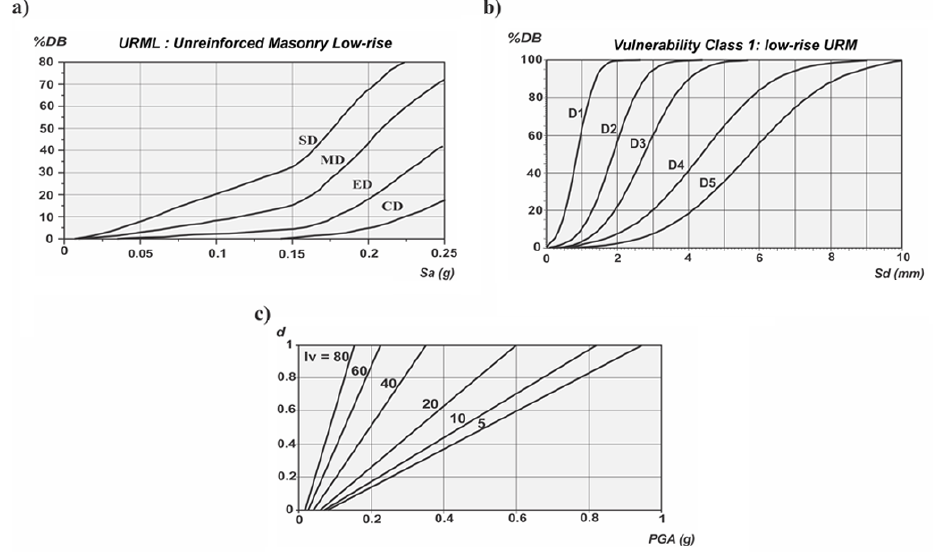
Fig. 4. Fragility and vulnerability curves. (a) and (b) HAZUS (Ebel, 2006) and Bsl (Lang and Bachmann, 2004) fragility curves; (c) relation- ship of vulnerability–damage–peak ground acceleration (PGA) according to Faccioli et al. (1999). DB: percentage of damaged buildings; Sa: spectral acceleration; Sd: spectral displacement; PGA: peak ground